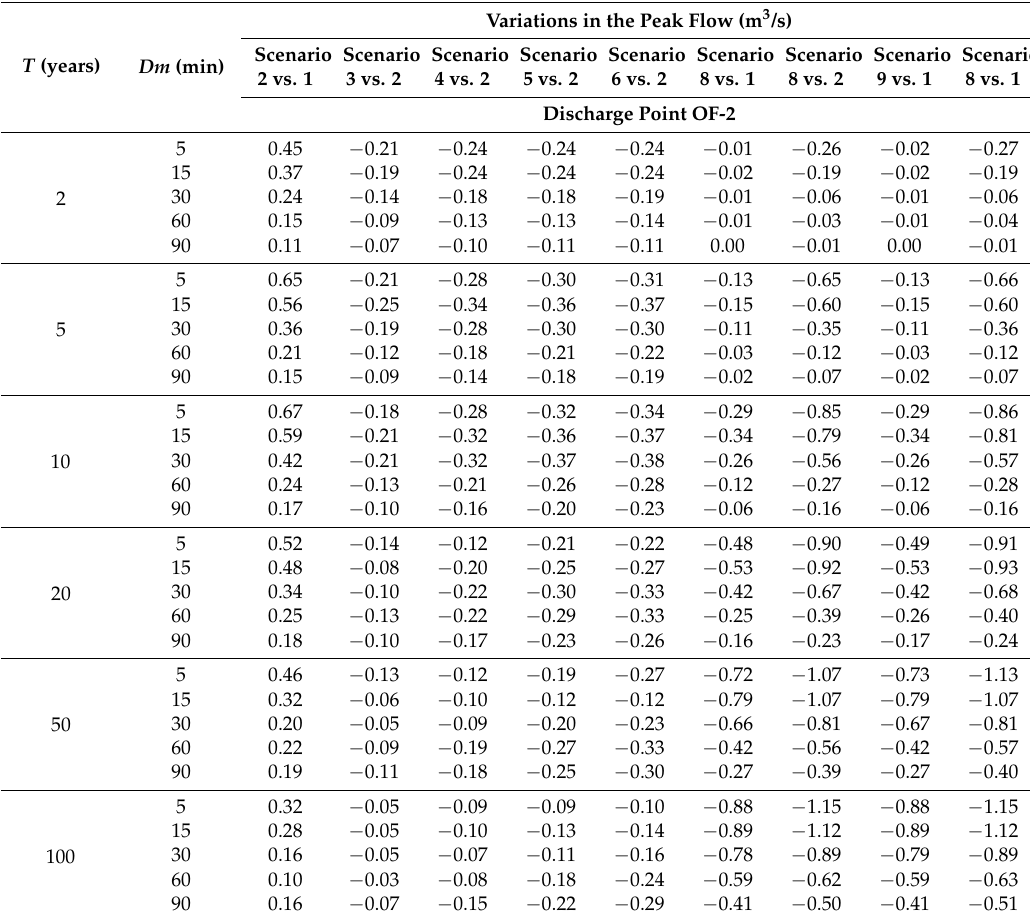
Table 7. Summary results with changes in the peak flow at the exit discharge point OF-2.